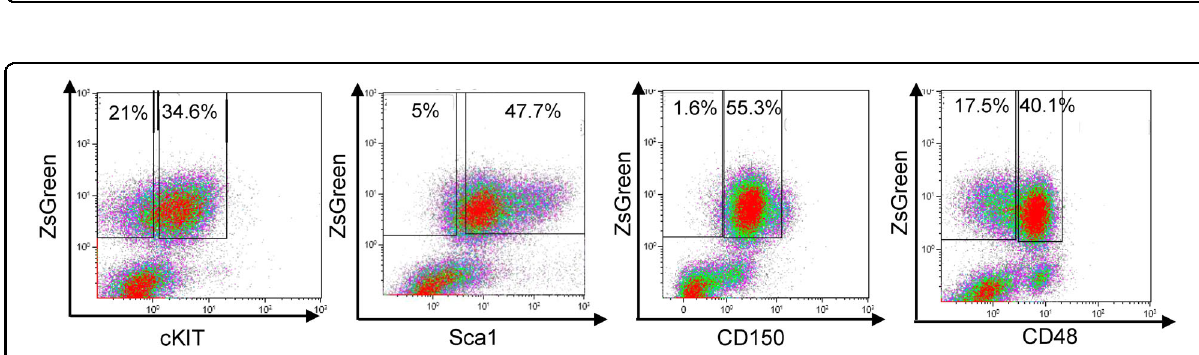
Fig. 6 Leukemia cells contain a subpopulation with distinct stem-cell markers. Representative FACS plots of ML23 expression of stem cell markers cKit, Sca1, CD150, and CD48, showing subpopulations of cKit − / + Sca1 + CD150 + CD48 − / + . n = 10 mice; Data are from one of at least three independent